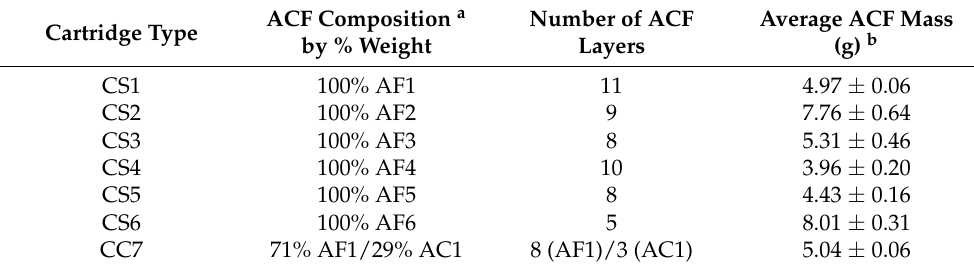
Table 1. Activated carbon fiber (ACF) composition, number, and mass of layers by cartridge